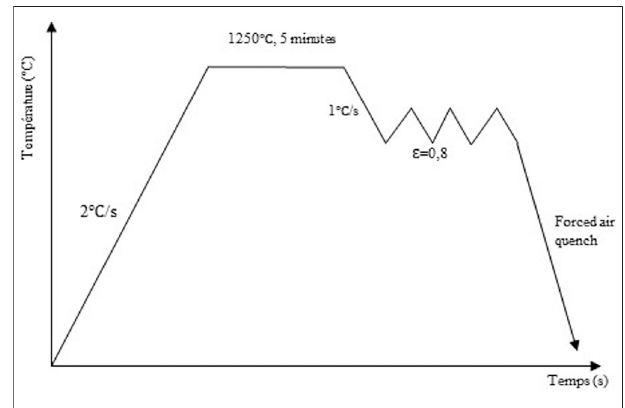
FIGURE 1 | Thermomechanical scheme of the experimental